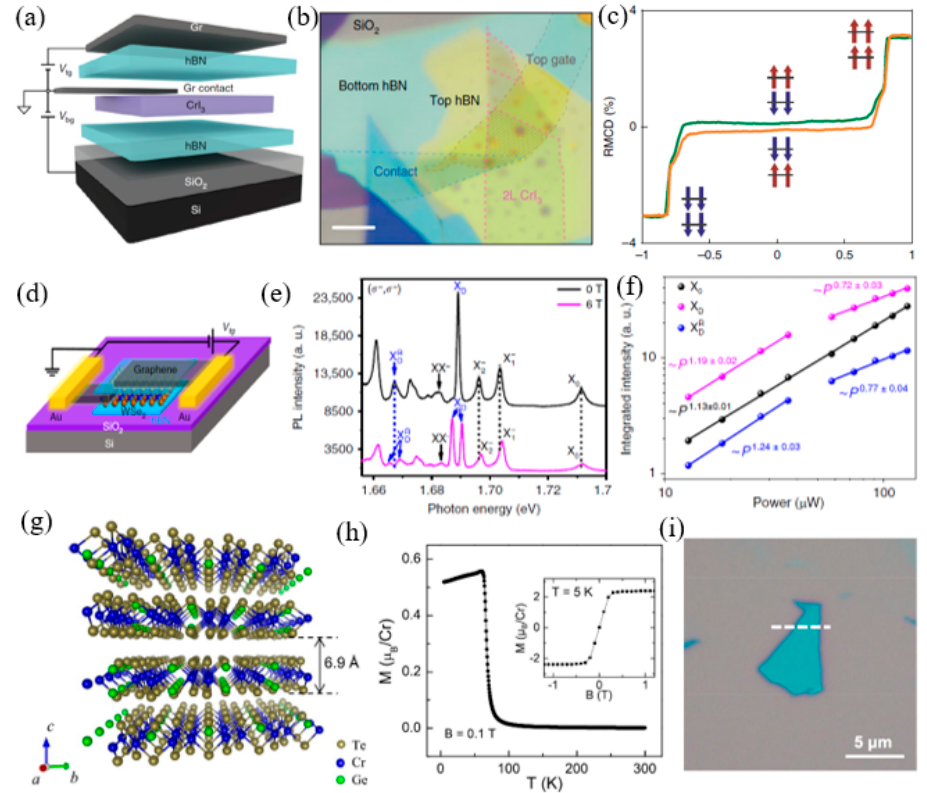
Figure 16. ( a ) Schematic diagram of a double-gated and double-decker CrI 3 device assembled. ( b ) False-color optical micrograph. ( c ) Variation curve of RMCD signal with zero grid voltage [289]. Copyright 2018 Nature Publishing Group. ( d ) BN encapsulated single-layer WSe 2 with graphene contact and top gate electrode. ( e ) The PL spectrum of the device at ( c ) 4.2 K. ( f ) Curve of integrated intensity and excitation power [290]. Copyright 2019 Nature Publishing Group. ( g ) The stratified crystal structure diagram of CGT along the direction of (0 0 0 1). ( h ) The magnetization of CGT single crystal as a function of the temperature change at 0.1 T magnetic field. Relationship between measured magnetization and magnetic field at 5 K (inset). ( i ) Classic 2D CGT chip optical image